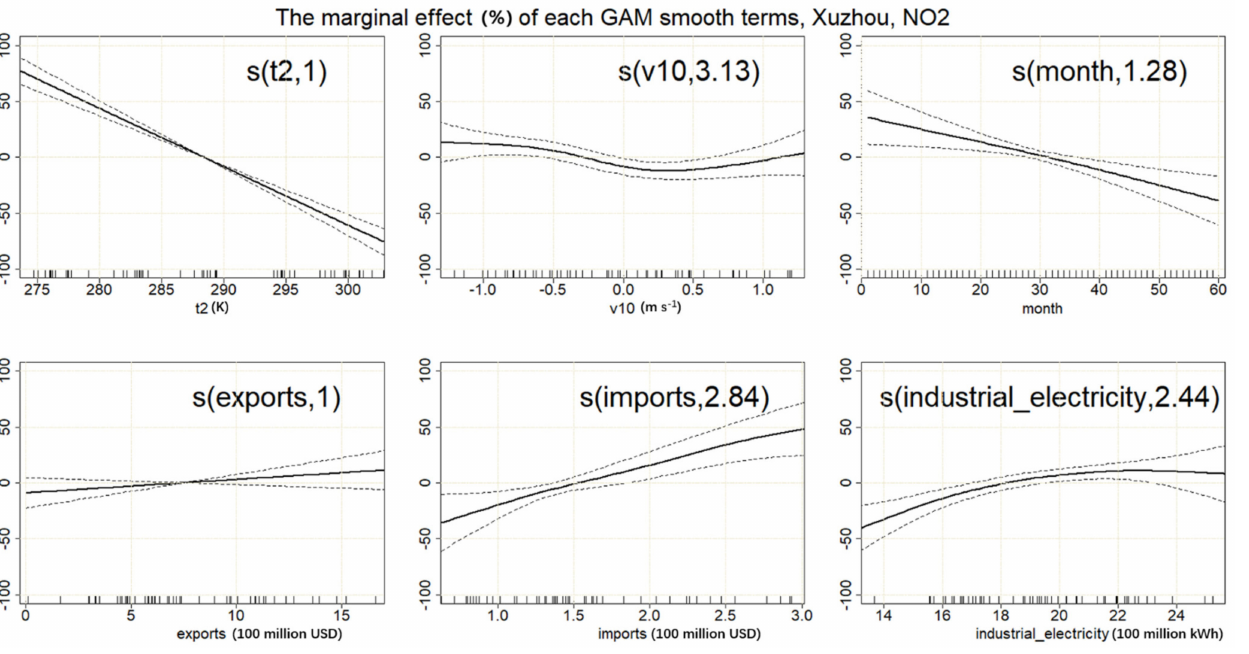
Figure 7. The marginal effect (%) of each GAM smooth term on NO 2 pollution of Xuzhou. The response curves of t2, v10, month, exports, imports, and industrial electricity are shown in separate